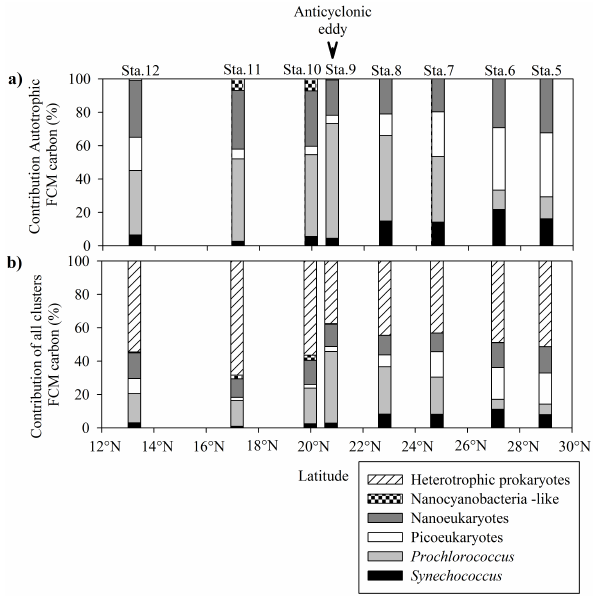
Fig. 12. Latitudinal contributions of (a) each autotrophic cluster defined by flow cytometry (FCM) to the whole autotrophic car- bon biomass integrated between surface and 200m depth. (b) Dis- plays the contribution (%) of each cluster (autotrophs and het- erotrophic prokaryotes) defined by flow cytometry to the whole car- bon biomass integrated between surface and 200m